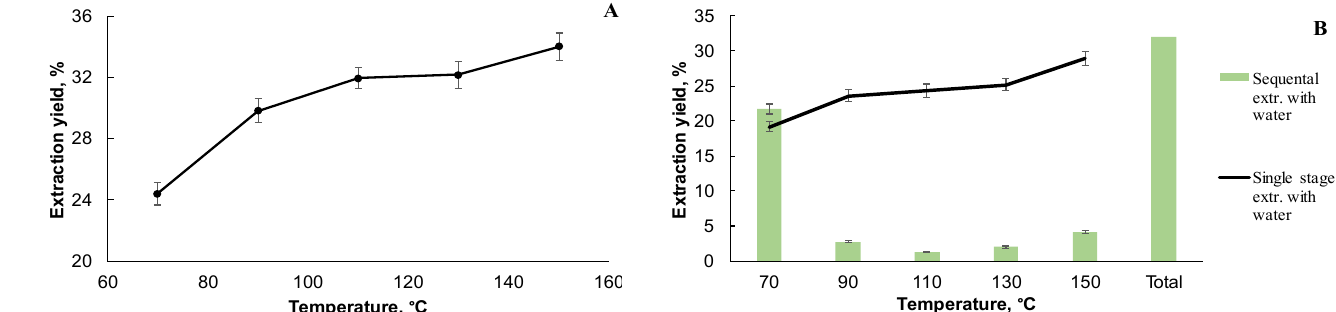
Figure 2. ( A ) Total extraction yield% of black alder bark sequential extraction with organic solvents, depending on extraction temperature at precustomized extraction parameters. ( B ) Total extraction yield% of black alder bark sequential and single stage extraction with deionized water, depending on extraction temperature at precustomized extraction parameters.